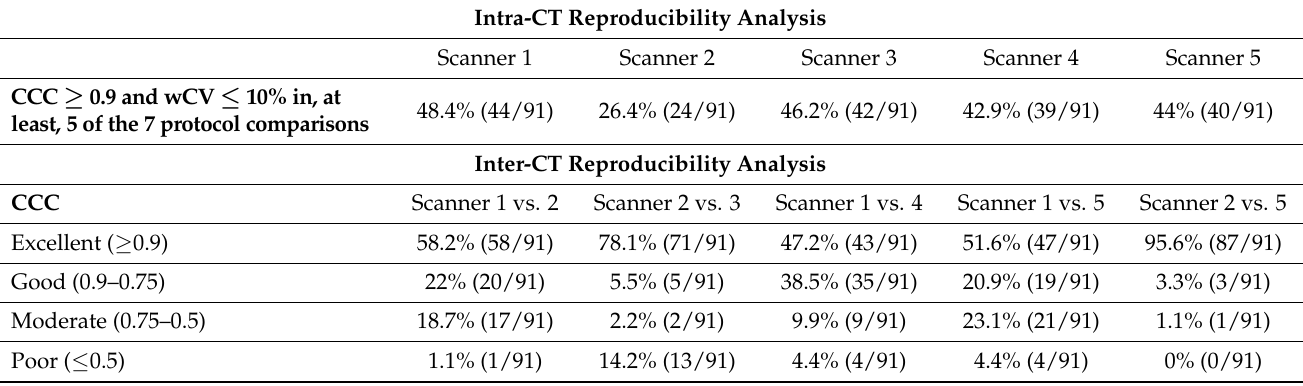
Table 4. Intra and inter-CT reproducibility results of the five different scanners regarding the 91 radiomic features analyzed. In all inter-scanner comparisons, protocol 1 of each CT was